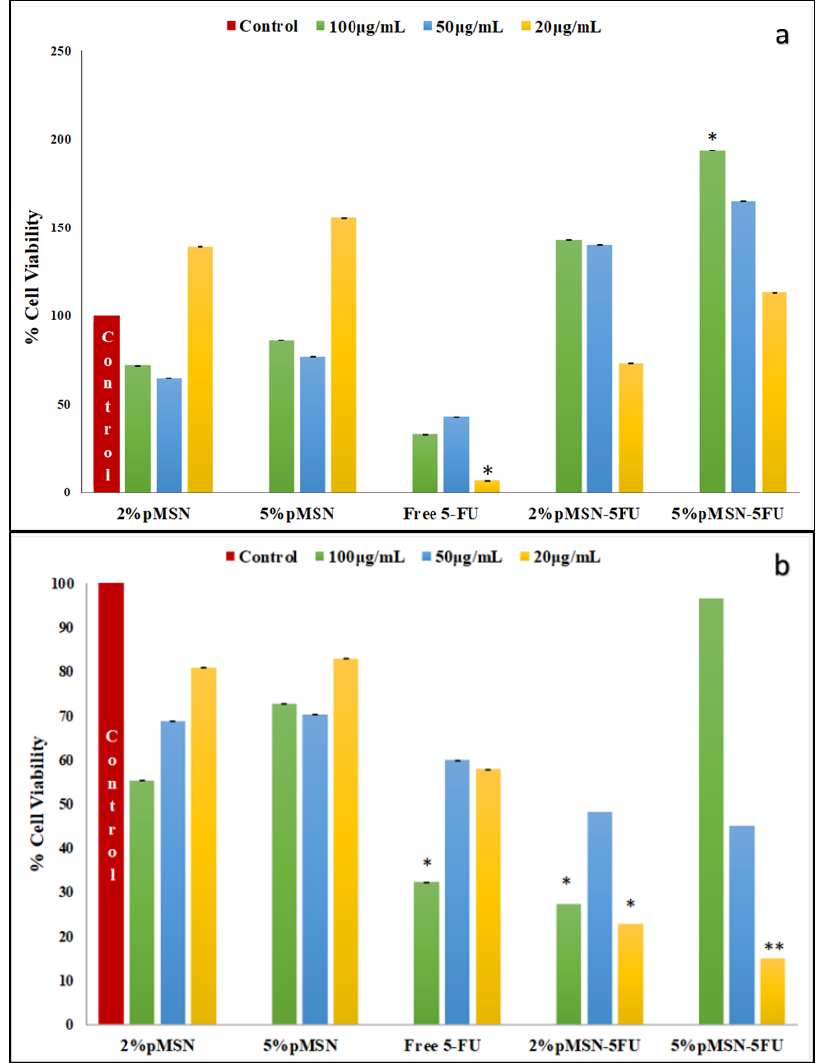
Figure 6. ( a ) MTT and ( b ) SRB cytotoxicity assay of f-MSNs and 5-FU-loaded MSNs administered at Figure 6. (a) MTT and (b) SRB cytotoxicity assay of f-MSNs and 5-FU-loaded MSNs administered at various concentrations (20, 50, and 100 µ g / mL) in Caco-2 cells. Data is represented as mean ± SD various concentrations (20, 50, and 100 μg/ mL) in Caco-2 cells . Data is represented as mean ± SD ( n = ( n = 3). * p < 0.05 and ** p < 0.01 were considered statistically 3). * p < 0.05 and ** p < 0.01 were considered statistically significant.